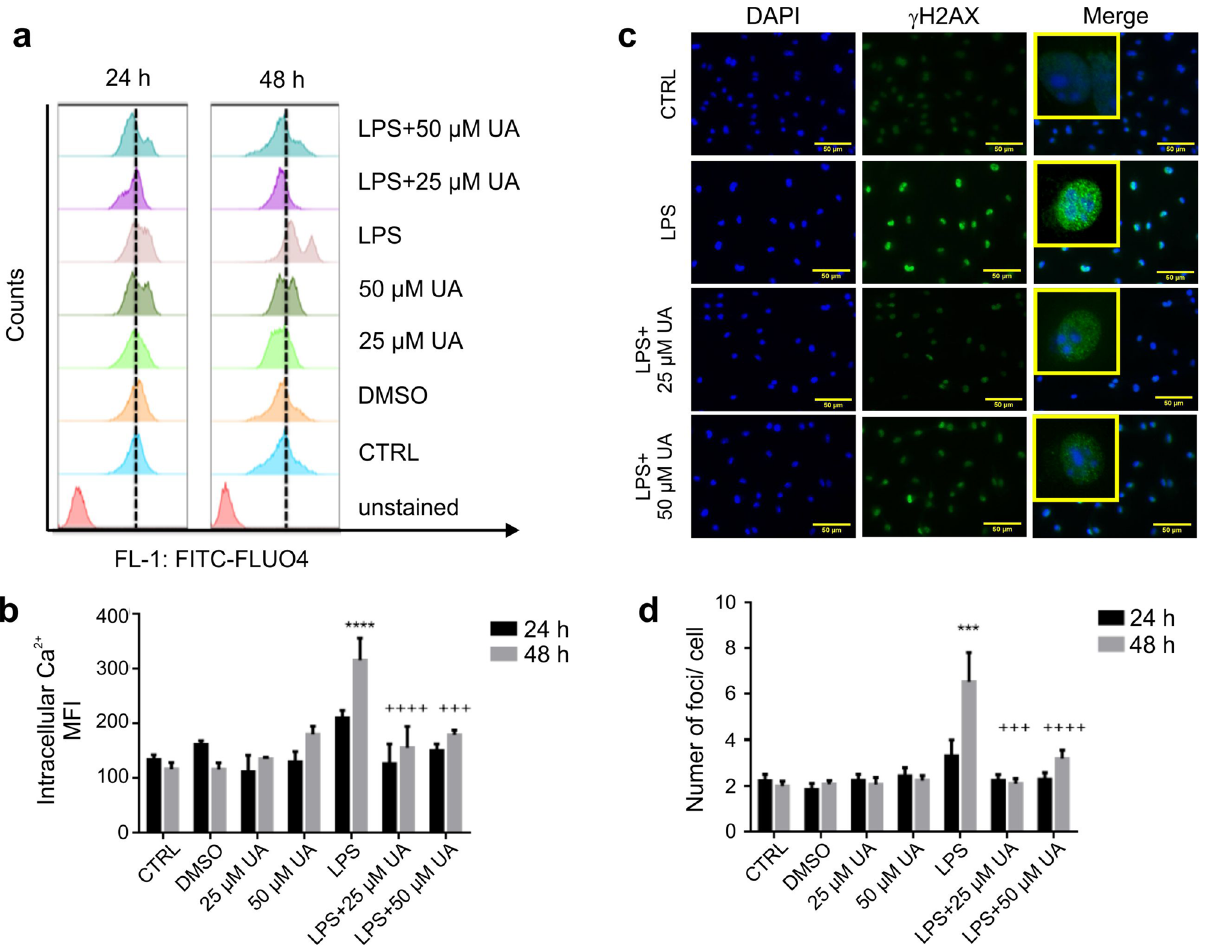
Figure 3. Urolithin A minimized the intracellular calcium concentration and ameliorated DSBs in LPS- stimulated murine BMDMs. ( a , b ) Murine BMDMs were stimulated with 1 µg/ml LPS in the presence or absence of UA (25 µM or 50 µM) for 24 h or 48 h. ( a ) Representative FACS histograms showing the effect of UA on stimulated BMDMs after 24 h and 48 h. The reference line was set at the peak of the control. ( b ) Arithmetic means ± SEM (n = 5–7) show a significant difference in intracellular Ca 2+ concentration between control and treated groups after 24 h and 48 h. The unstimulated BMDMs were used as untreated control. DMSO was used as negative control. The intracellular Ca 2+ was measured with flow cytometry. (c) Murine BMDMs were stimulated by 1 µg/ml of LPS with or without UA (25 µM or 50 µM) for 2 h (images not shown) and 48 h. After 48 h, LPS induced DSBs indicated by a prominent green immunofluorescence for Ser139- phosphorylated H2AX. Treatment with UA recorded a remarkable decrease in number of γH2AX foci. Nuclei were counterstained with DAPI (blue). The magnifications are 20-fold and scale bar represents 50 μm. The unstimulated and untreated BMDMs were used as control. DMSO was used as negative control. ( d ) Graph indicates the number of γH2AX foci per cell after indicated time points. Representative images and arithmetic means ± SEM from four independent experiments (600 cells were counted). Two way ANOVA was used and ***( p < 0.001) indicate statistically significant differences compared to respective control, whereas +++( p < 0.001), and ++++( p < 0.0001) indicate statistically significant differences compared to LPS. Abbreviations: DMSO, dimethyl sulfoxide; UA, urolithin A; LPS,